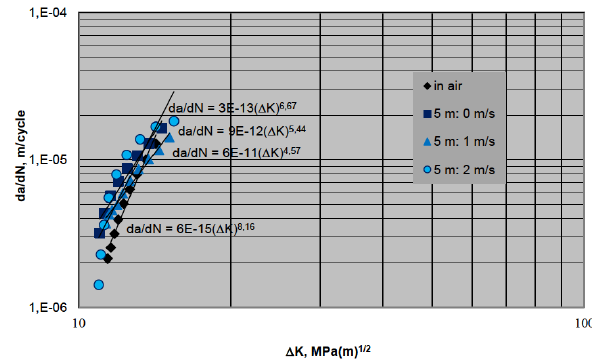
Figure 9: da/dN - ∆ K diagram for underwater wet welding in water depth of 5 m. Table 3: Paris constant (m) and material constant (C)